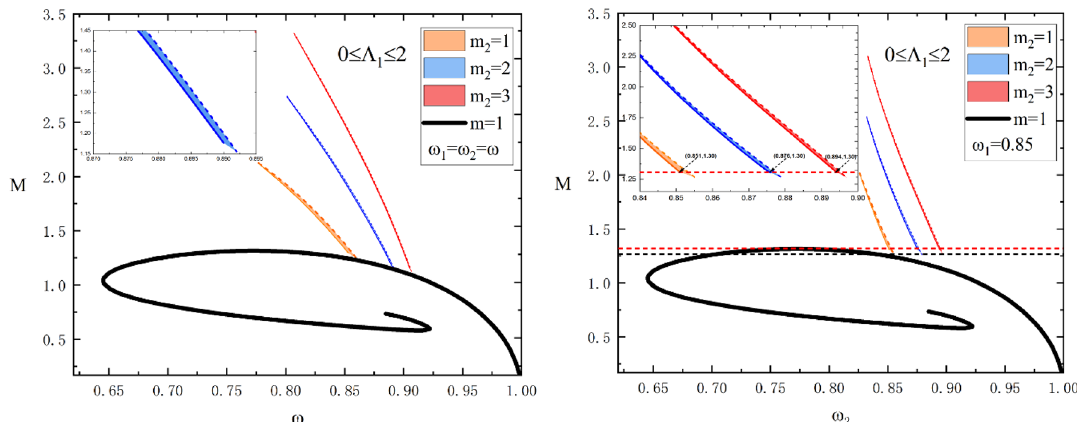
Figure 1 . Left : the mass M of the SIMBSs as a function of the synchronized frequency ω with the azimuthal harmonic indexes m 2 = 1 , 2 , 3 . Right : the mass M of the SIMBSs as a function of the nonsynchronized frequency ω 2 with ω 1 = 0 . 85 . The horizon red dashed line indicates the mass M = 1 . 30 , and the black dashed line indicates the mass M = 1 . 26 . In both panels, the dashed, solid lines denote Λ 1 = 0 and Λ 1 = 2 , respectively. The black spiral curve indicates the ground state with an azimuthal harmonic index m = 1 . All solutions have µ 1 = 1 , µ 2 = 0 . 93 , and m 1 = 1